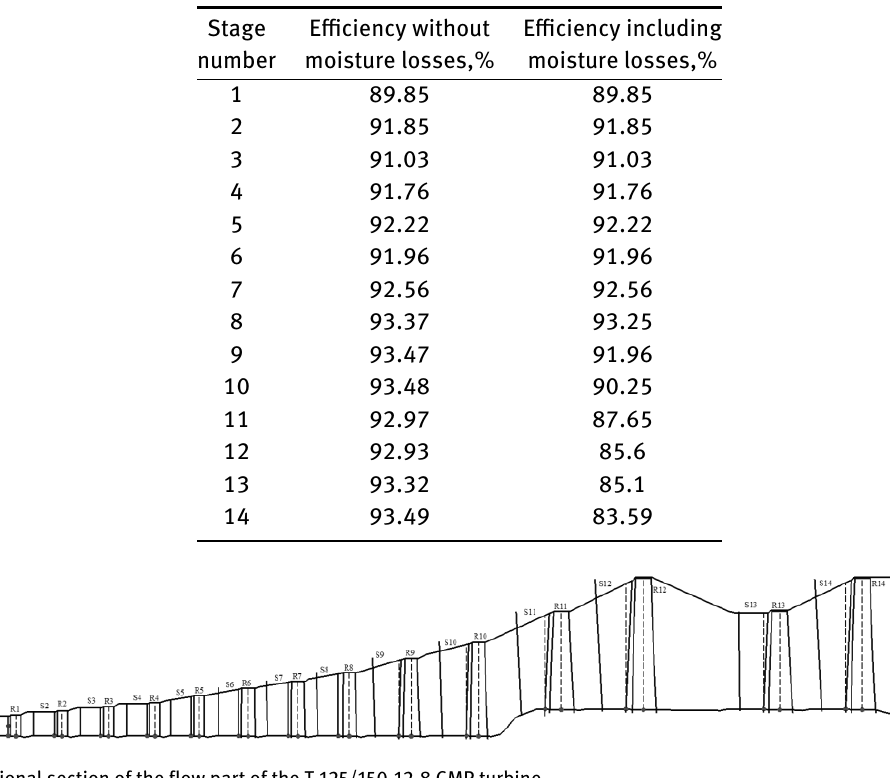
Table 4: Eflciency of CMP T-125/150-12,8 turbine stages